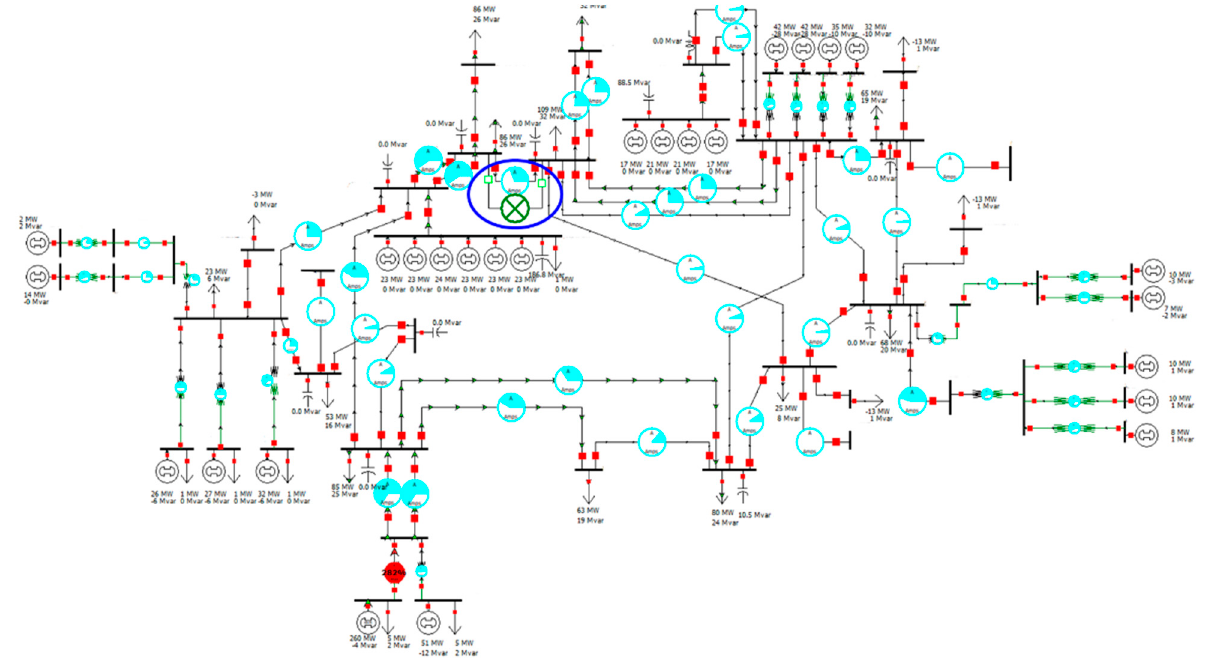
Figure 8. Systematic diagram for N-1 contingency analysis (CASE 2); blue line circle refers to the broken line for contingency analysis.